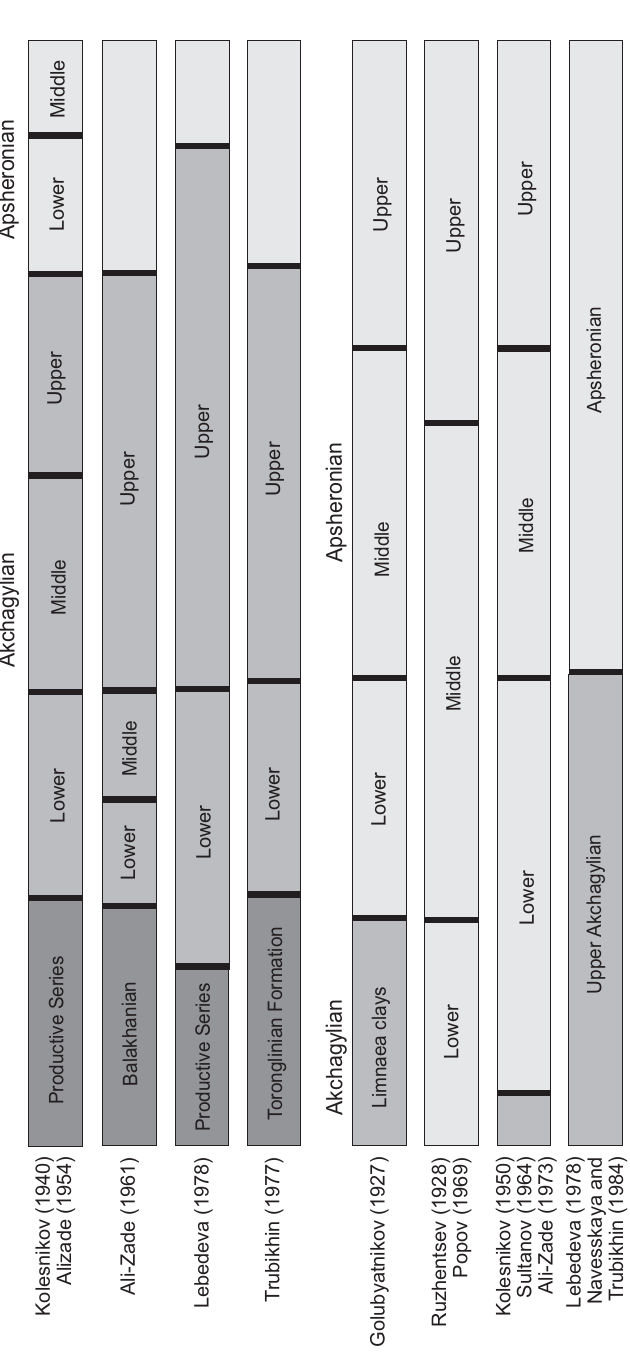
Fig. 4. Schemes of subdivision of Akchagylian and Apsheronian regio- stages adapted from Filippova